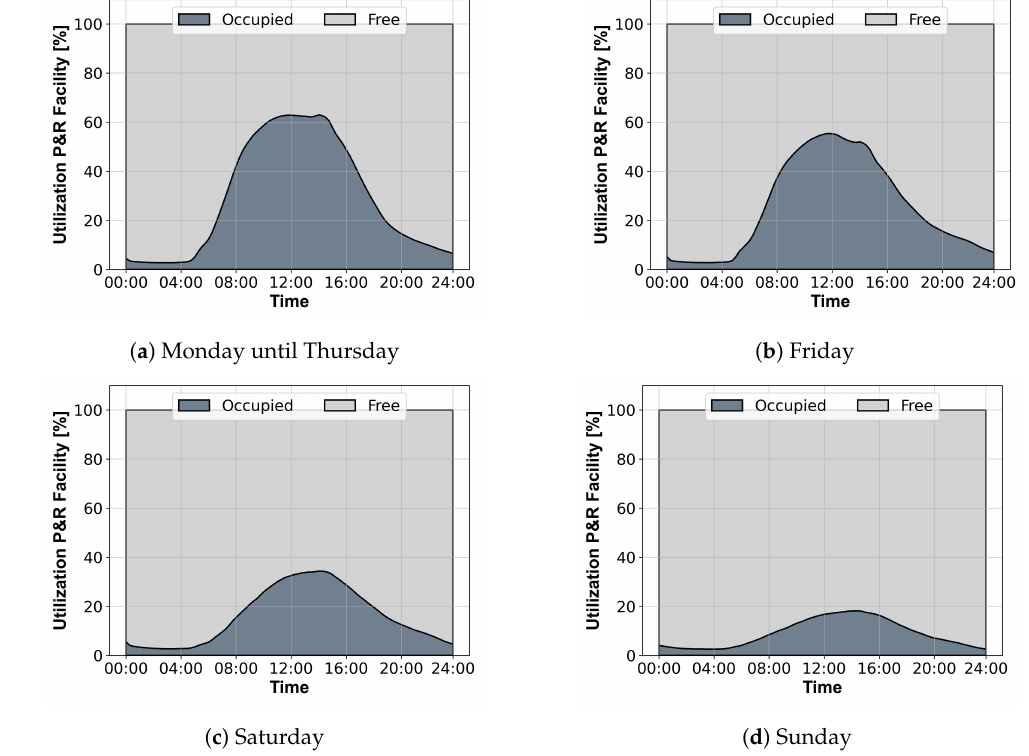
Figure 9. Utilization of the Park and Ride facility on different types of